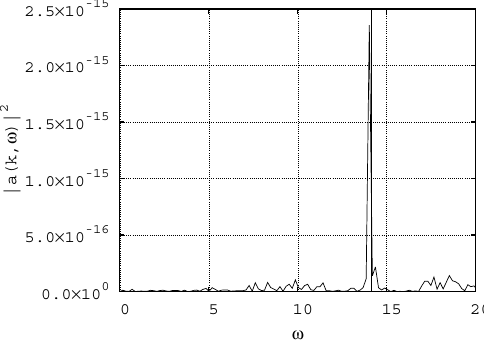
Figure 13. Spectral line of the harmonic k = (0, 200). Only the con- densate was suppressed.